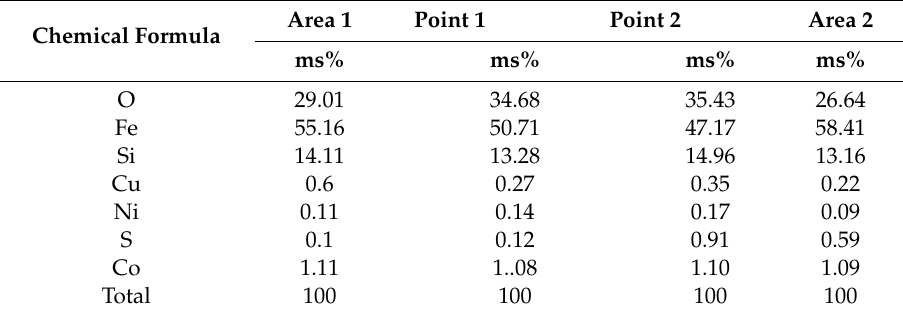
Figure 2. Respective marked areas / points of image in Figure 1 analyzed under EPMA. Table 2. EPMA-EDS analysis of areas / points marked in Figure 2 (ms%—mass